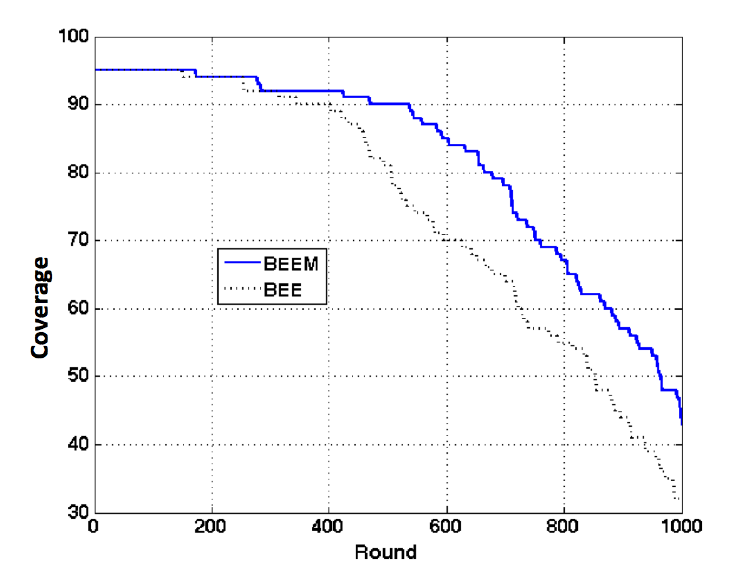
Figure 9. Network sensing coverage comparison between BEE and